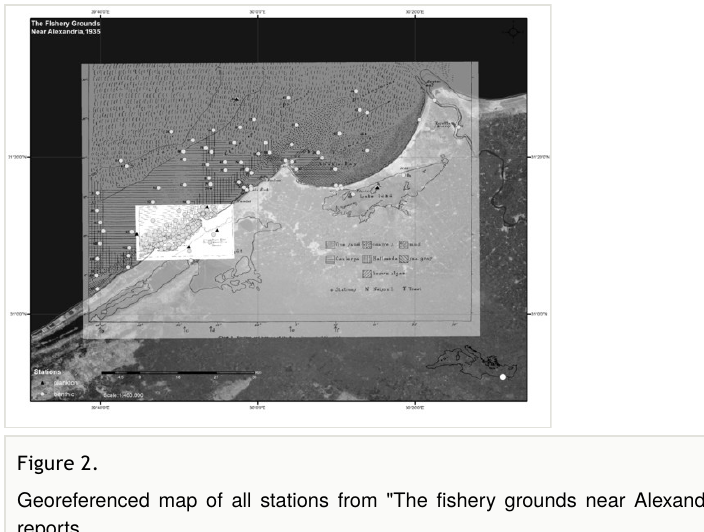
Figure 2. Georeferenced map of all stations from "The fi shery grounds near Alexandria" macrofaunal